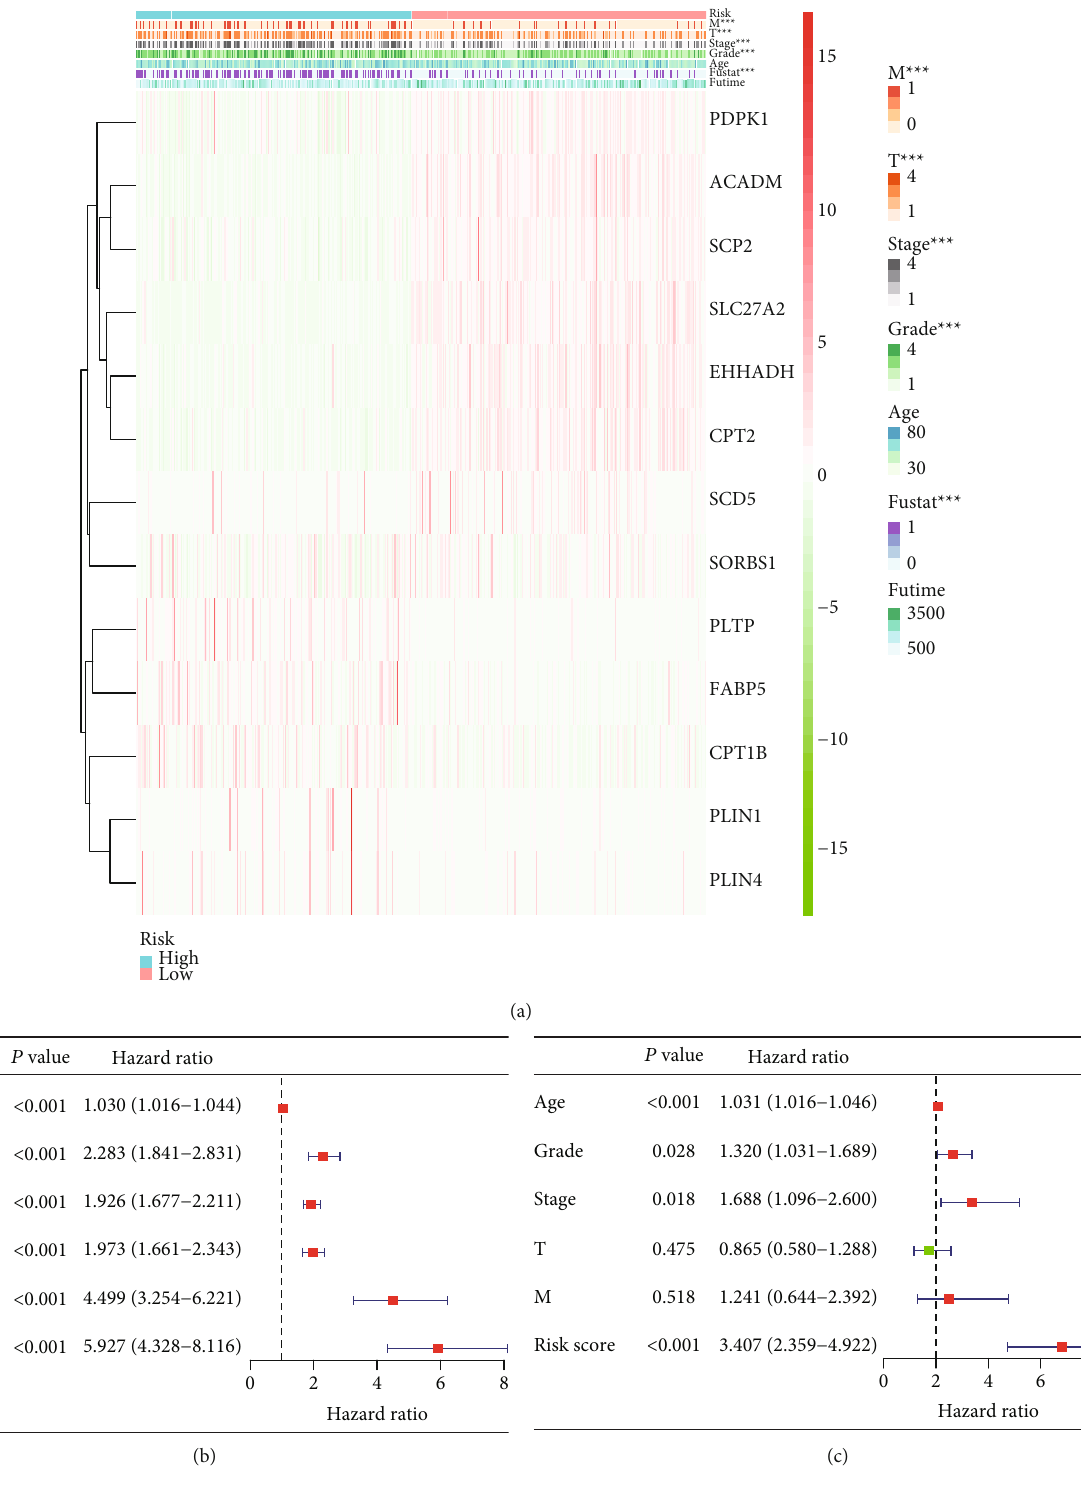
Figure 4: (a) Based on this risk model, the analysis correlates with the clinicopathological characteristics. (b) Univariate Cox regression analysis. The results of univariate Cox regression analysis showed clinicopathological parameters such as age, grade, stage, T (tumor), M (metastasis), and risk score of the new survival model with the OS of KIRC patients. (c) Multivariate Cox regression analysis. The results of multivariate Cox regression analysis showed clinicopathological parameters such as age, grade, stage, and risk score of the new survival model with the OS of KIRC patients. ∗∗∗ P < 0 : 001